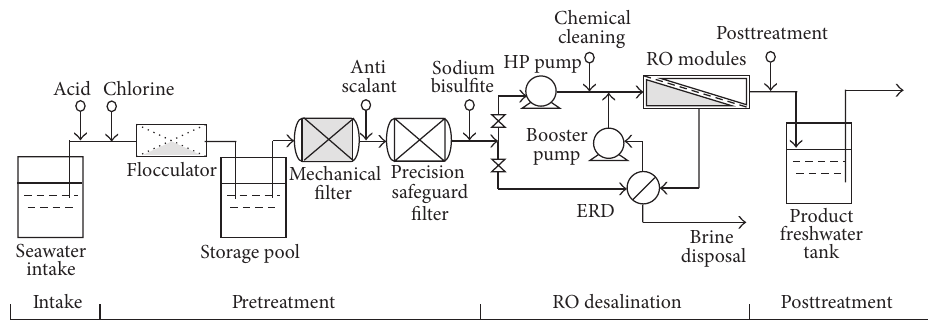
Figure 1: Schematic diagram of a single SWRO desalination unit.